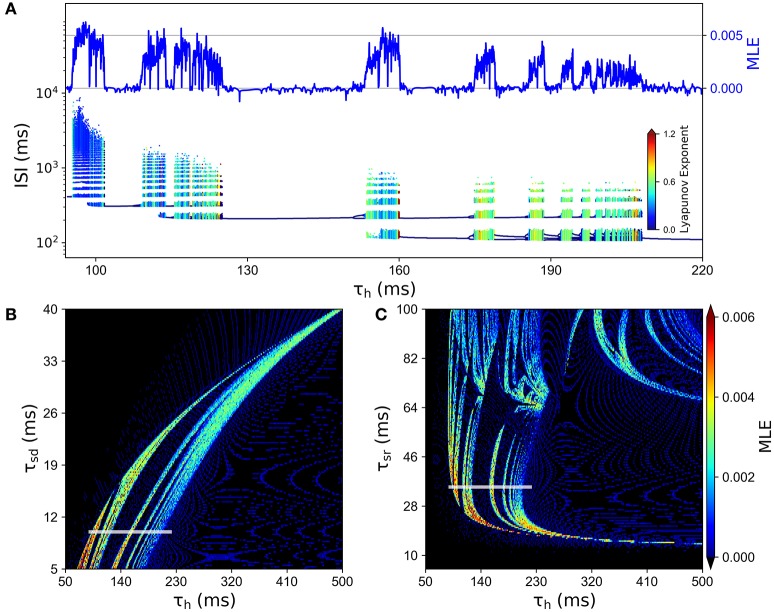
Chaotic behavior dependency on the time constants of slow conductances τsd, τsr and τh. (A) ISI bifurcation diagram as τh is changed. Color of ISIs represents the LE of the ISI sequence. At the top, the line depicts the MLE of the voltage trajectories for the same values of τh. (B) MLE of voltage trajectories for different combinations of τh and τsd. (C) MLE for different combinations of τh and τsr. In (B,C), the white line indicates the corresponding region of the parameter space that is explored in (A).